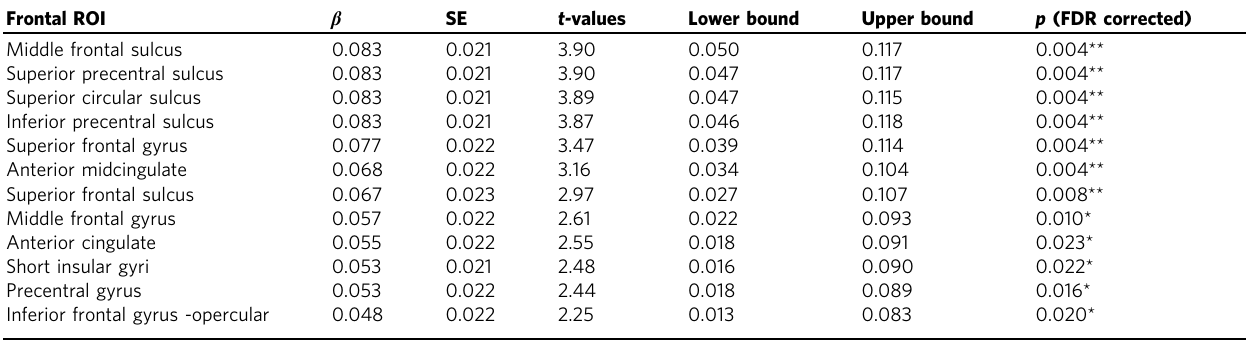
Table 1 Low-level feature-speci fi c informational connectivity during imagery within the frontal cortex. Frontal ROI β SE t- values Lower bound Upper bound p (FDR corrected) Middle frontal